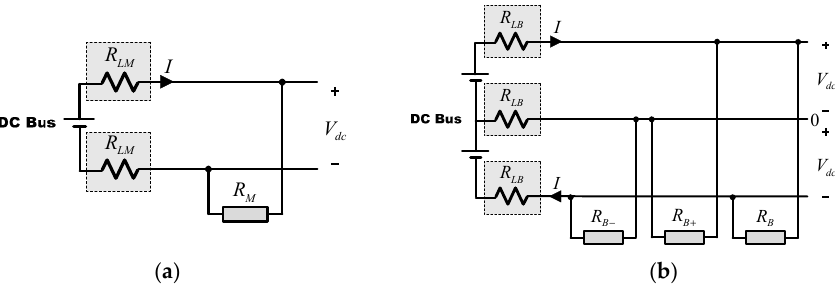
Figure 2. ( a ) Monopolar DC grid; ( b ) bipolar DC grid.